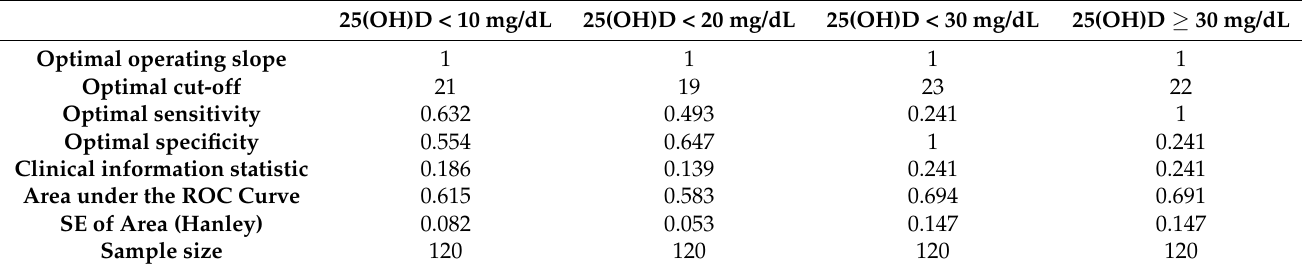
Table 5. ROC analysis results using the 4 reference